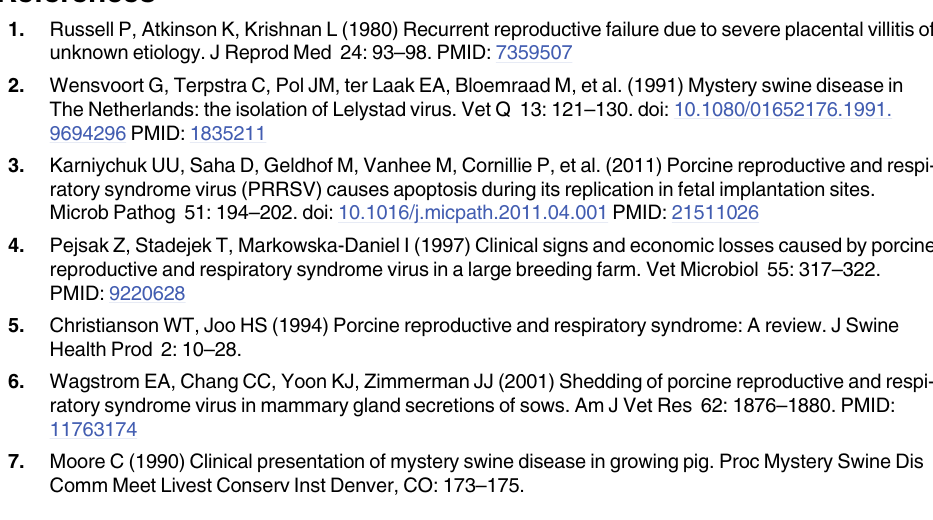
S1 Table. Whole blood counts from different genotype animals with reference